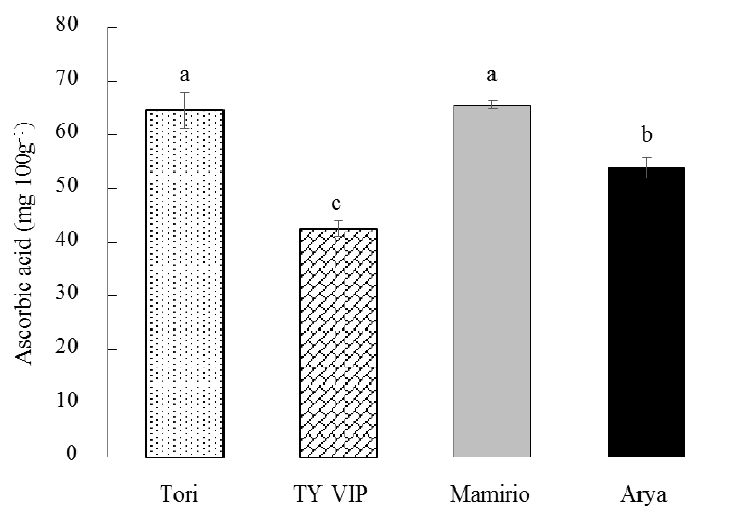
Figure 3. Ascorbic acid content of ‘Tori’, ‘TY VIP’, ‘Mamirio’, and ‘Arya’ tomato cultivars at the commercial pink ripening stage. The bars with different letters indicate a significant difference ( p < 0.05) between cultivars. The vertical bars represent the standard error of the means ( n = 5).